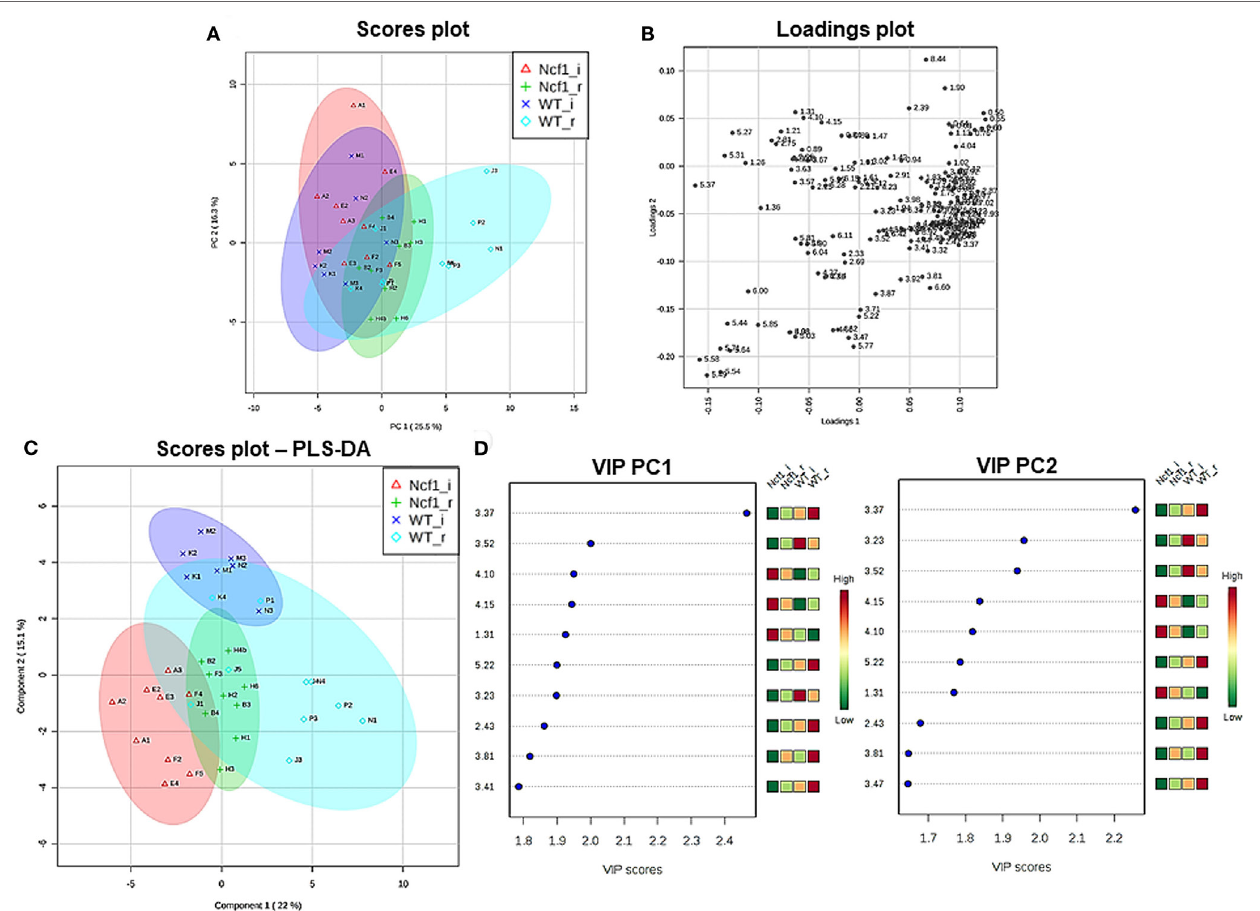
FigUre 8 | The systemic metabolic profile after a second period of dextran sulfate sodium-induced colitis is markedly distinct between mice bearing the Ncf1-mutation (Ncf1) and the wild-type (WT) group. However, the two recovery groups tend to diverge from the induced groupings and edge toward a common metabolic profile. Principal component analysis (PCA) and partial least squares–discriminant analysis (PLS–DA) analysis of 1 H spectra of Ncf1 vs WT after the second colitis induction (i) and recovery (r) groups. The PCA scores plot explains 41.8% of the total variance (PC1 = 25.5%, PC2 = 16.3%) (a) and the loadings plot shows the δ of each variable (bucket) (B) . The PLS–DA model (c) and variable importance in projection (VIP) variables (D) for the four groups ( r 2 = 0.70, q 2 =